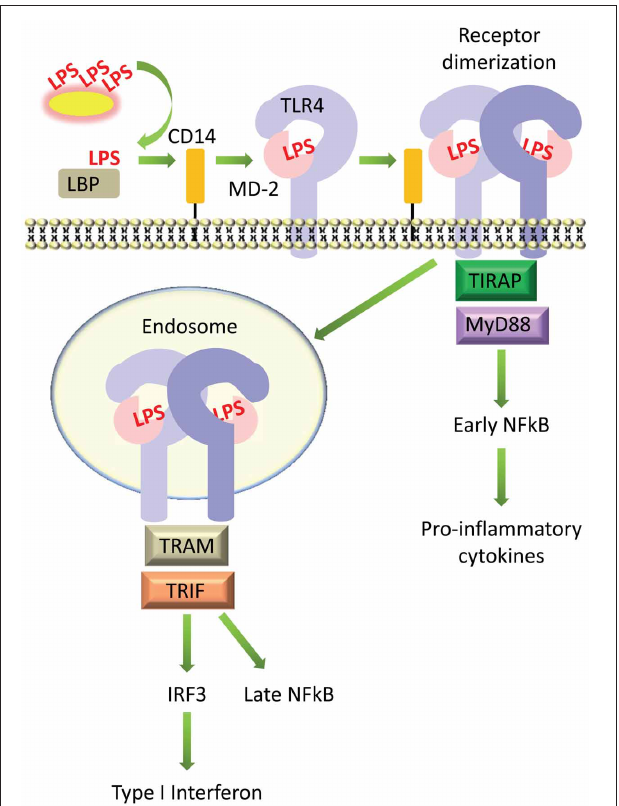
FIGURE 1 | Schematic of the basic structure of lipopolysaccharide. LPS consists of three regions: from the bottom, lipid A (chair structure indicates di-glucosamine headgroup, red circles indicate phosphate groups, squiggly lines indicate acyl chains), core sugars, and O-antigen, which consists of repeating units (denoted in brackets, with an “n”) of oligosaccharides.